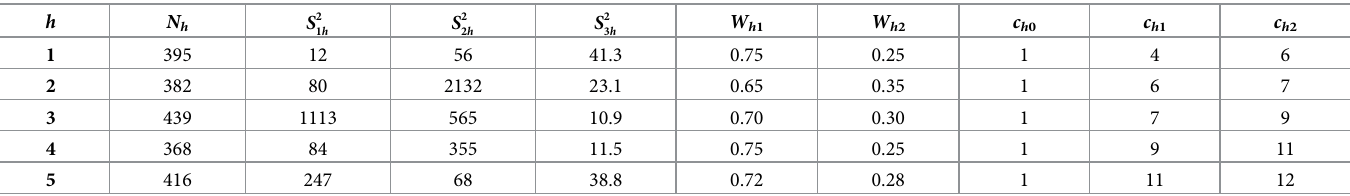
Table 3. Data related to the strata and their characteristics for the nonresponse